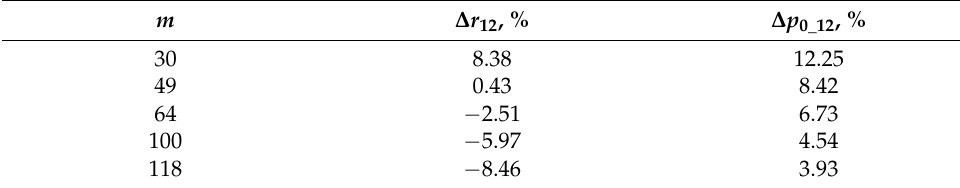
Table 10. The differences of indices r and p 0 for Method 1 and Method 2 in